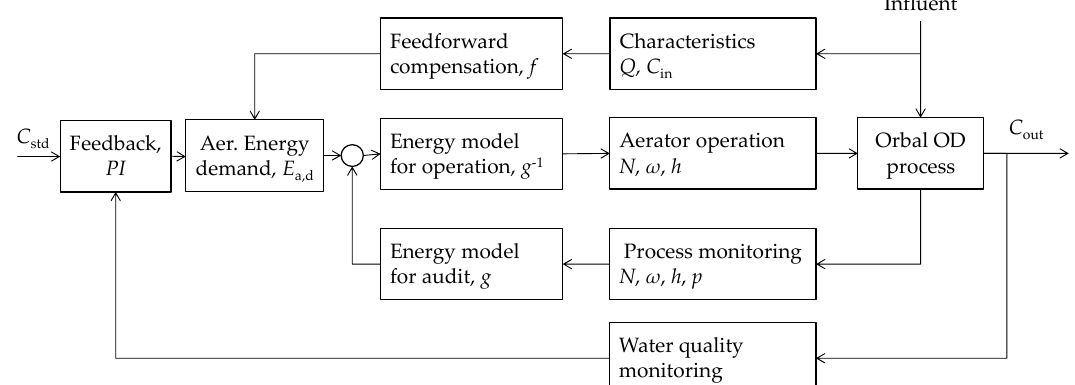
Figure 3. The feedforward control strategy basing on aeration energy to manipulate surface aerators in the Orbal oxidation ditch (OD). The parameters are same as those in Equation (6). C out is actual ammonia concentration in effluent and C std is the set point of ammonia as the discharged criteria. PI is proportional and integral algorithm. f and g are model functions. N , ω , h and p are model variables. Q is influent flow rate and C in is influent ammonia concentration.